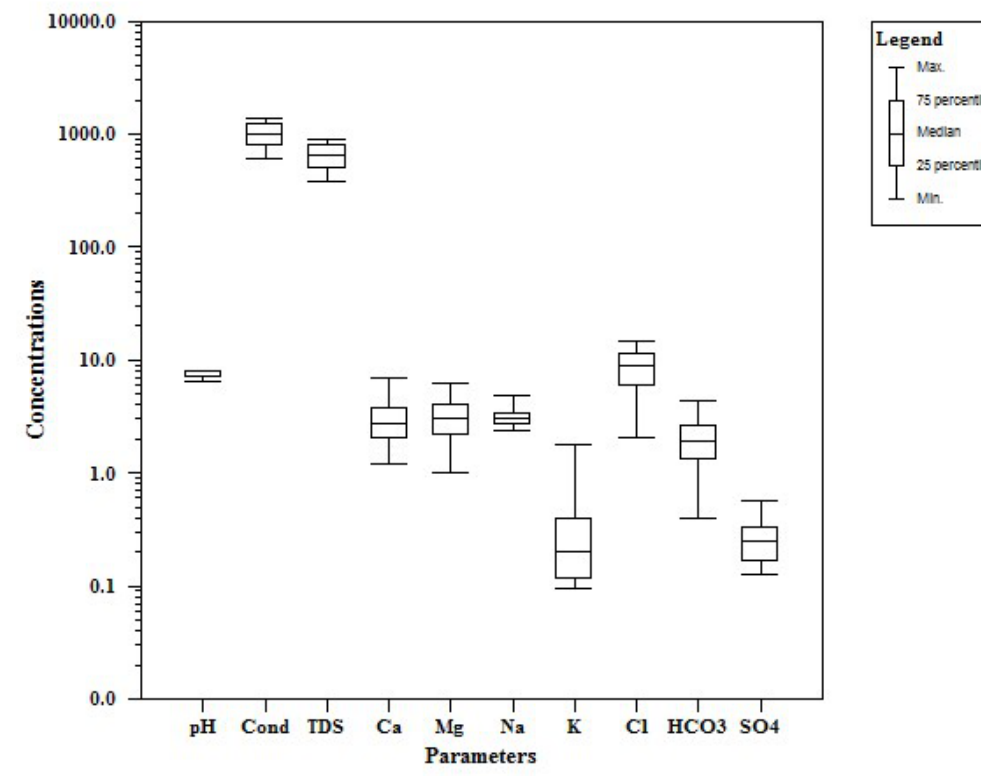
Figure 2. Box plot for the chemical composition of groundwater (all values in mg / L, except pH and EC in µ s / cm).